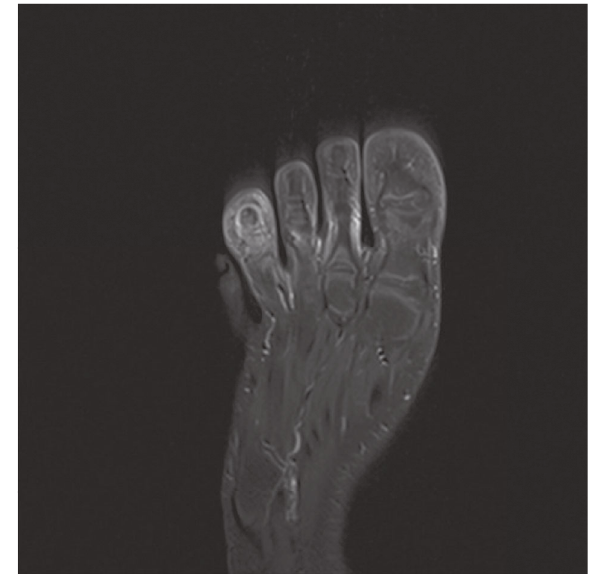
Figure 3: Gadolinium-enhanced T1-weighted images on MRI, showing the relative avascular nidus surrounded by hypervascular in fl amed tissues.